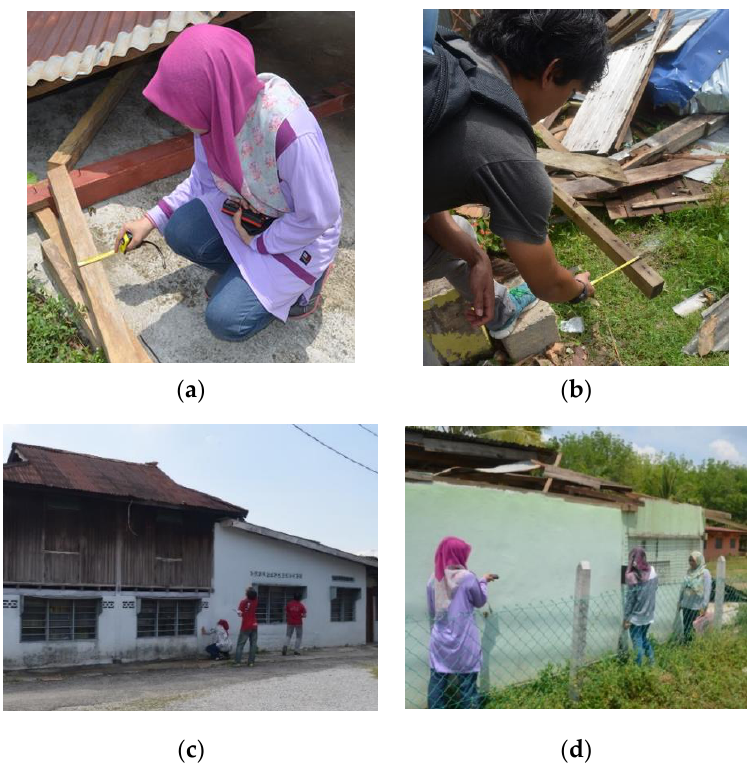
Figure 3. Measurements of the ( a ) roof truss width; ( b ) roof truss thickness; ( c ) height of the house; and ( d ) width of the